Question: Write a single sentence explaining what this figure depicts.
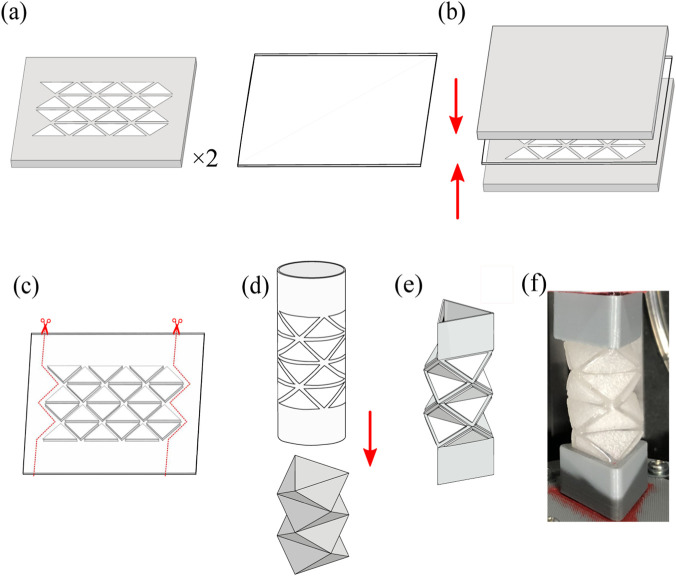
Answer: Fabrication procedure of the origami-patterned endoskeleton. (a) Cut HUMOFIT®F Typeand HUMOFIT®A Typesheets, and place the HUMOFIT®F Typesheets into the positioning mold. (b) Sandwich the HUMOFIT®A Typesheet between the HUMOFIT®F Type-lined molds and heat-weld the layers. (c) Remove the mold and trim the margins at both ends. (d) Heat-weld the ends to form a cylindrical shape, place the sheet into an origami mold, and heat it to memorize the shape. (e) After heating and natural cooling, remove the mold to complete the three-dimensional structure. (f) Picture of fabricated endoskeleton.